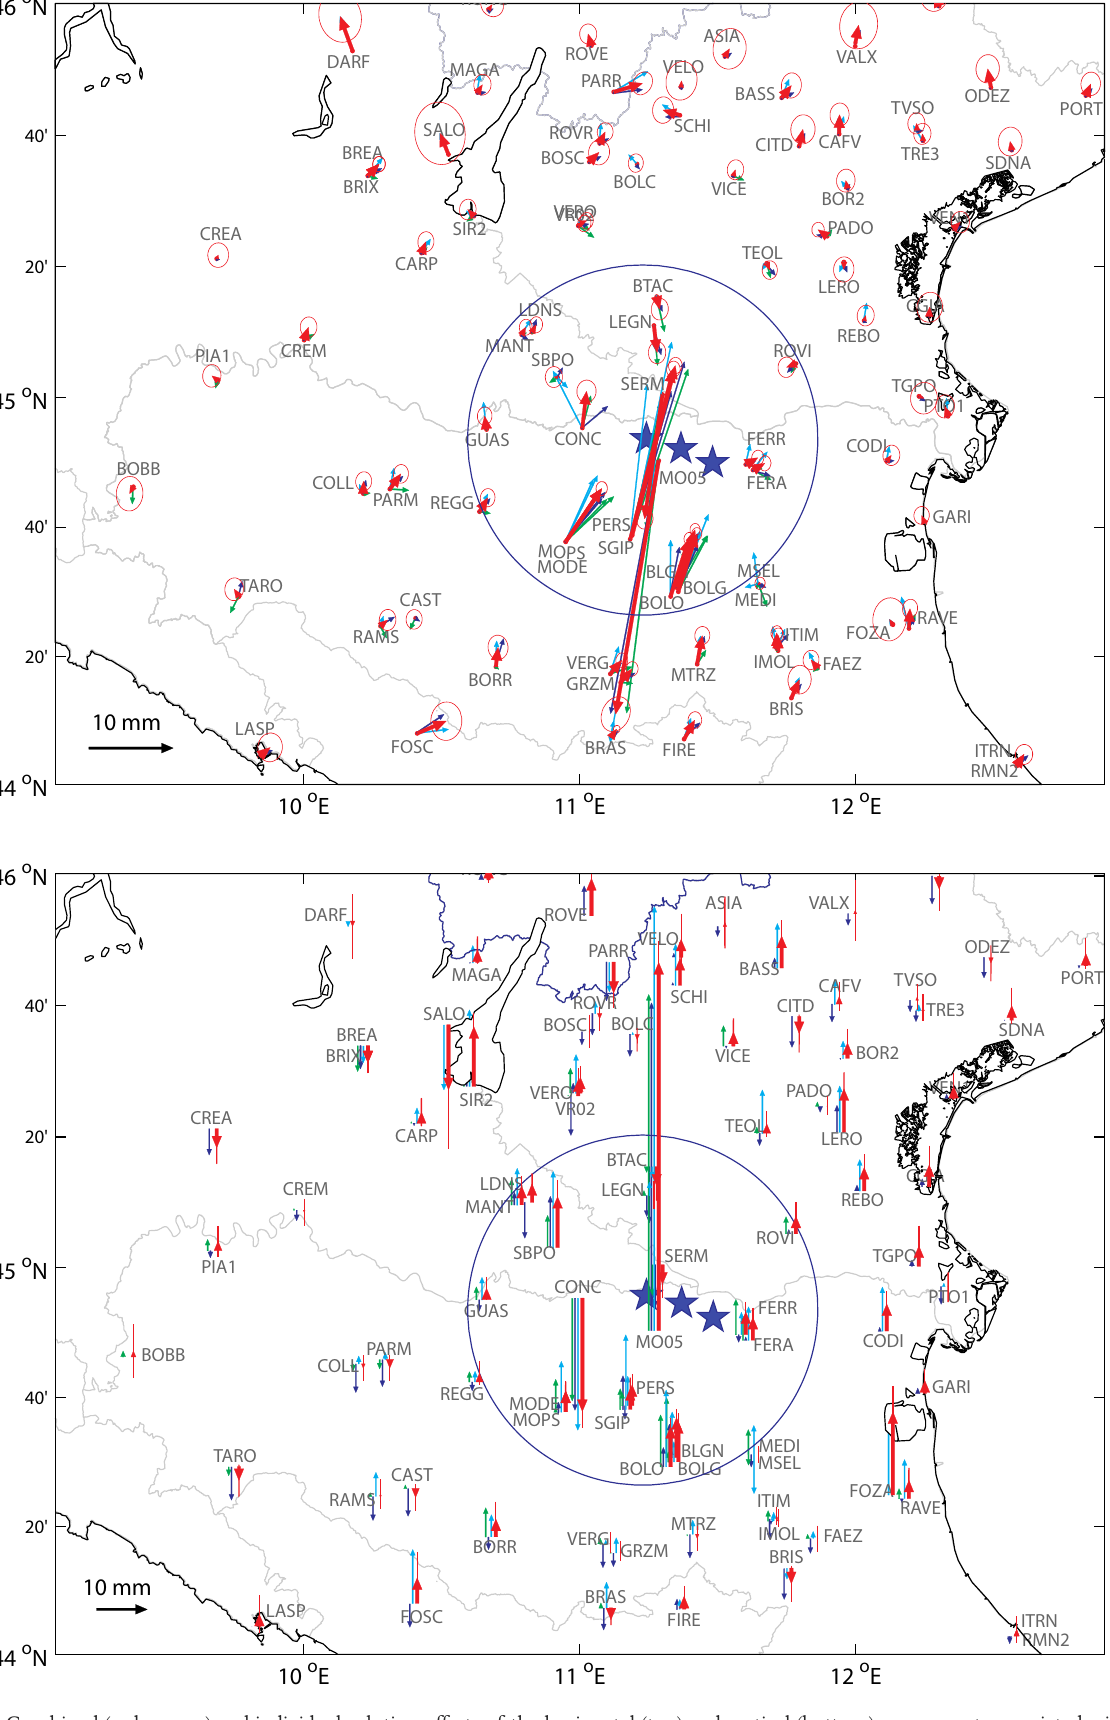
Figure 1. Combined (red arrows) and individual solution offsets of the horizontal (top) and vertical (bottom) components associated with the May 20, 2012, seismic events. The individual solutions are represented in green (BERNESE), cyan (GIPSY) and blue (GAMIT). Stars, epicenters of the M >5 events; circle, delimitation of the 50-km range from the mainshock (M 5.9); error ellipses, one-sigma confidence